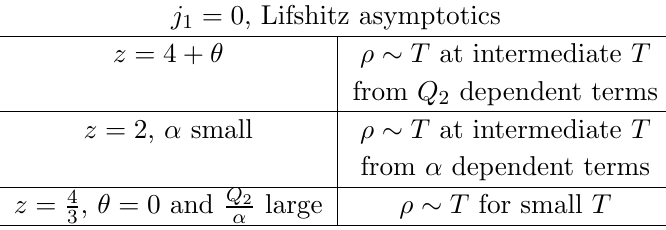
Table 2 . Lifshitz asymptotics, linearly dependent sources. A few representative cases